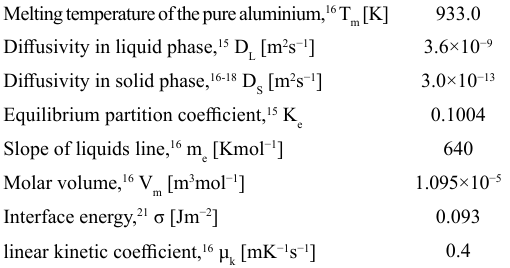
Table 1: Physical properties of the binary alloy (Al-Cu).